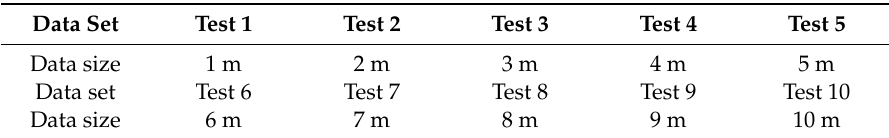
Table 5. Experimental collection data